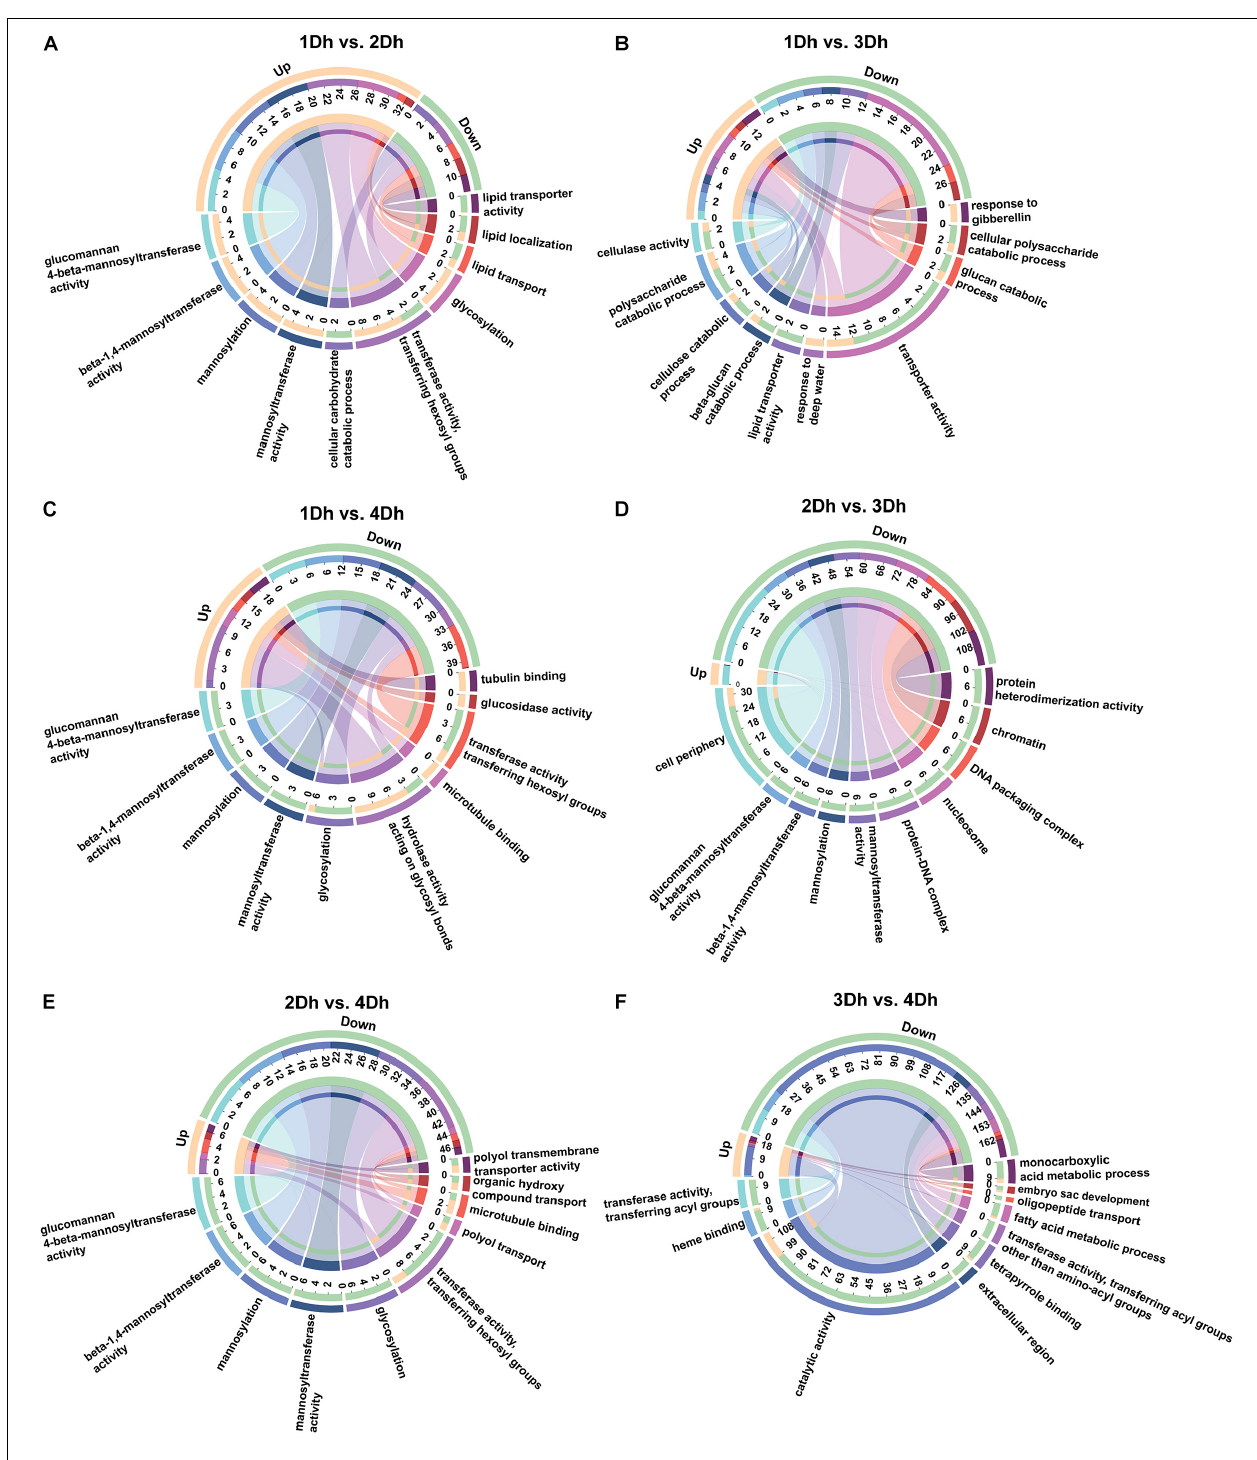
FIGURE 2 | GO enrichment circos plot of DEGs. The upper half-circle indicates the number of up and down regulated DEGs in each comparison group, orange indicates up-regulation and green indicates down-regulation. The outermost circle of the lower half-circle indicates the GO terms, and different colors represent different GO terms; the inner circle indicates the number of up- and down-regulated DEGs in each GO term. The top 10 GO terms that are significantly enriched are shown in the figure. The chords in the figure point from up- and down-regulated genes to GO terms, and the thickness of the chords indicates the abundance of up- and down-regulated genes in each GO term. (A) 1Dh vs. 2Dh. (B) 1Dh vs. 3Dh. (C) 1Dh vs. 4Dh. (D) 2Dh vs. 3Dh. (E) 2Dh vs. 4Dh. (F) 3Dh vs. 4Dh.